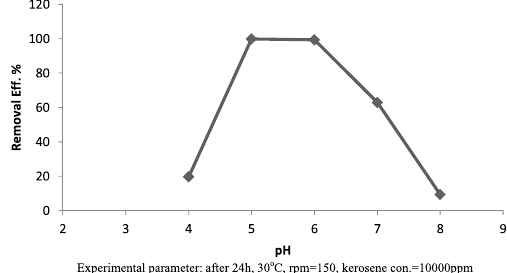
Fig. 2. Effect of initial pH on kerosene degradation by Klebsiella pneumonia sp.